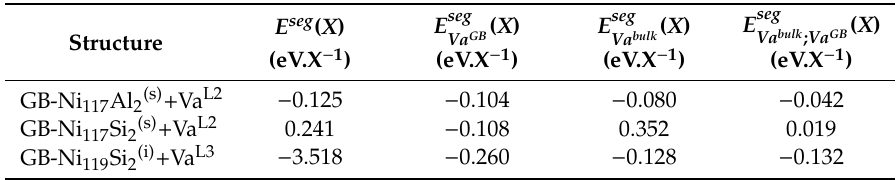
Table 11. Segregation energies of impurity segregating ( a ) from the bulk to GB ( E seg (X) , Equation (7)); ( X ) , Equation (22)); ( c ) from the bulk with Va to GB ( E seg ( X ) , ( b ) from the bulk to GB with Va ( E seg Va GB Va bulk ( X ) , Equation (24)) Equation (23)) and ( d ) from the bulk with Va to GB with Va ( E seg Va bulk ; Va GB